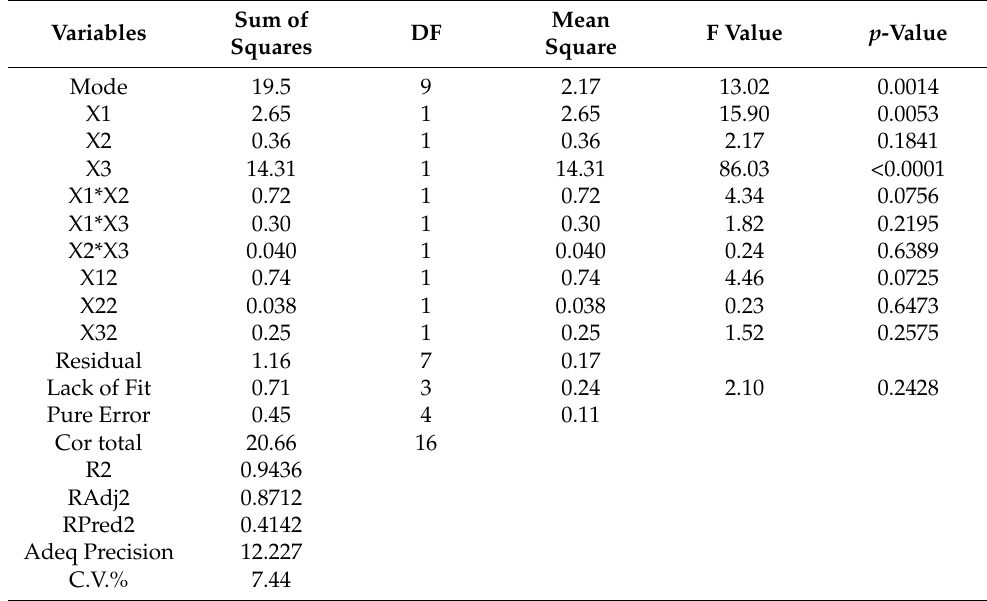
Table 4. Analysis of variance for the BBD experimental results for TFW.